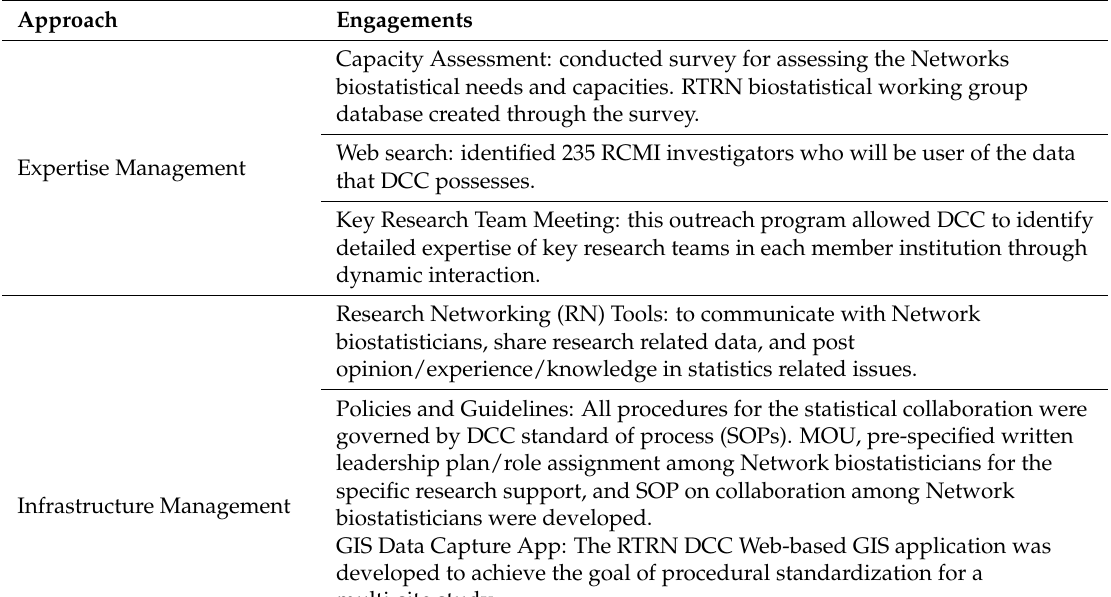
Table 2. Strategic Collaboration Engagement Performed by the